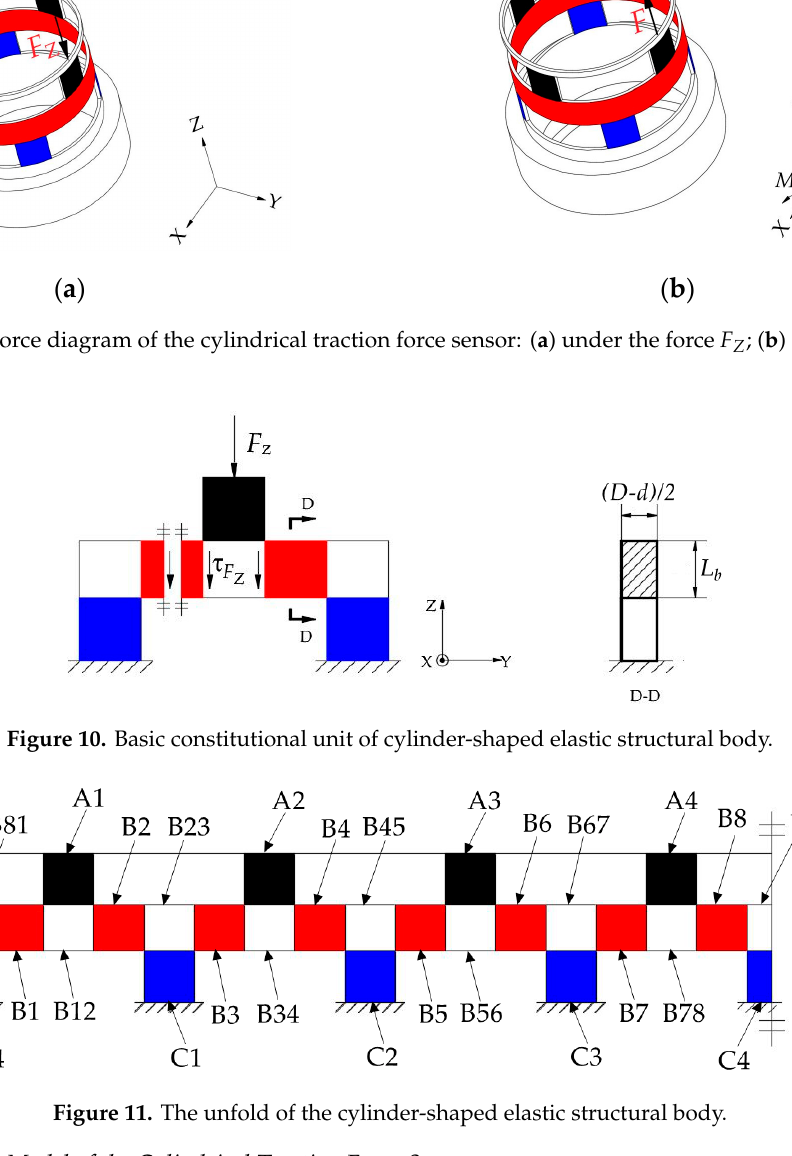
Figure 11. The unfold of the cylinder-shaped elastic structural body.